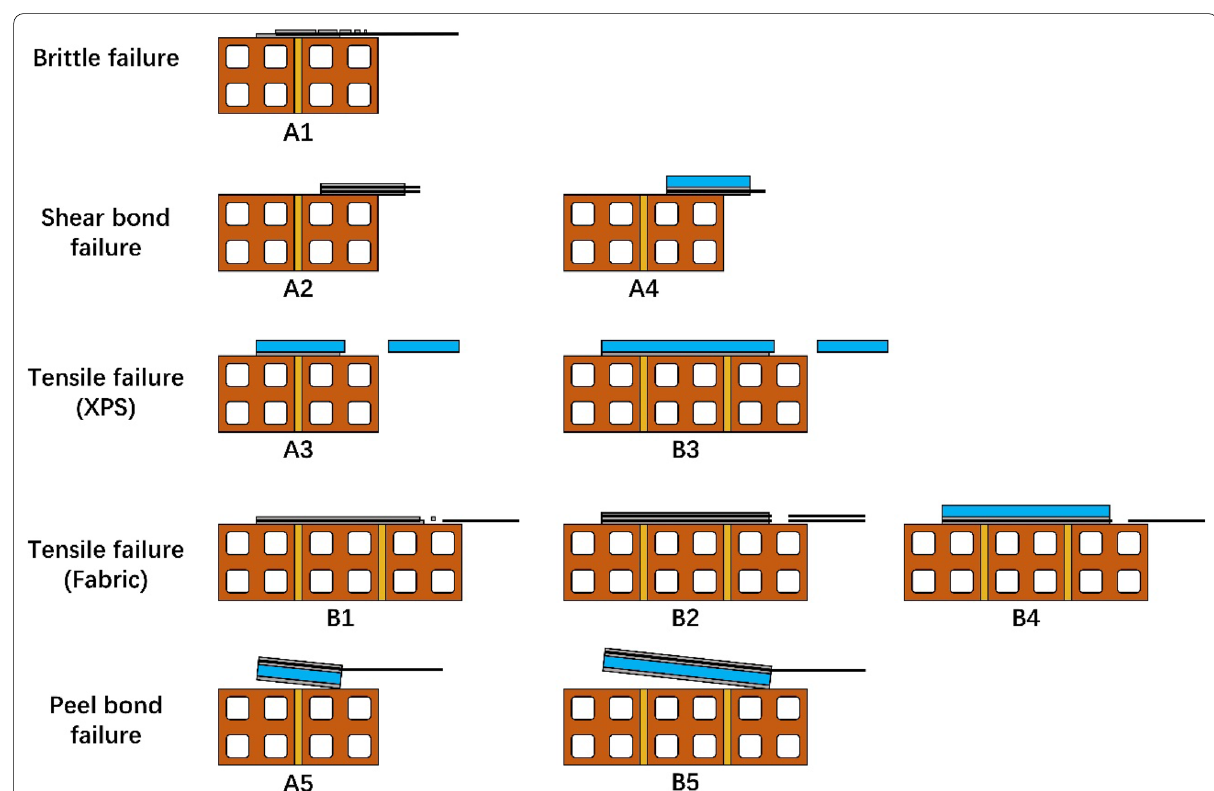
Fig. 11 Classification of failure modes in shear bond